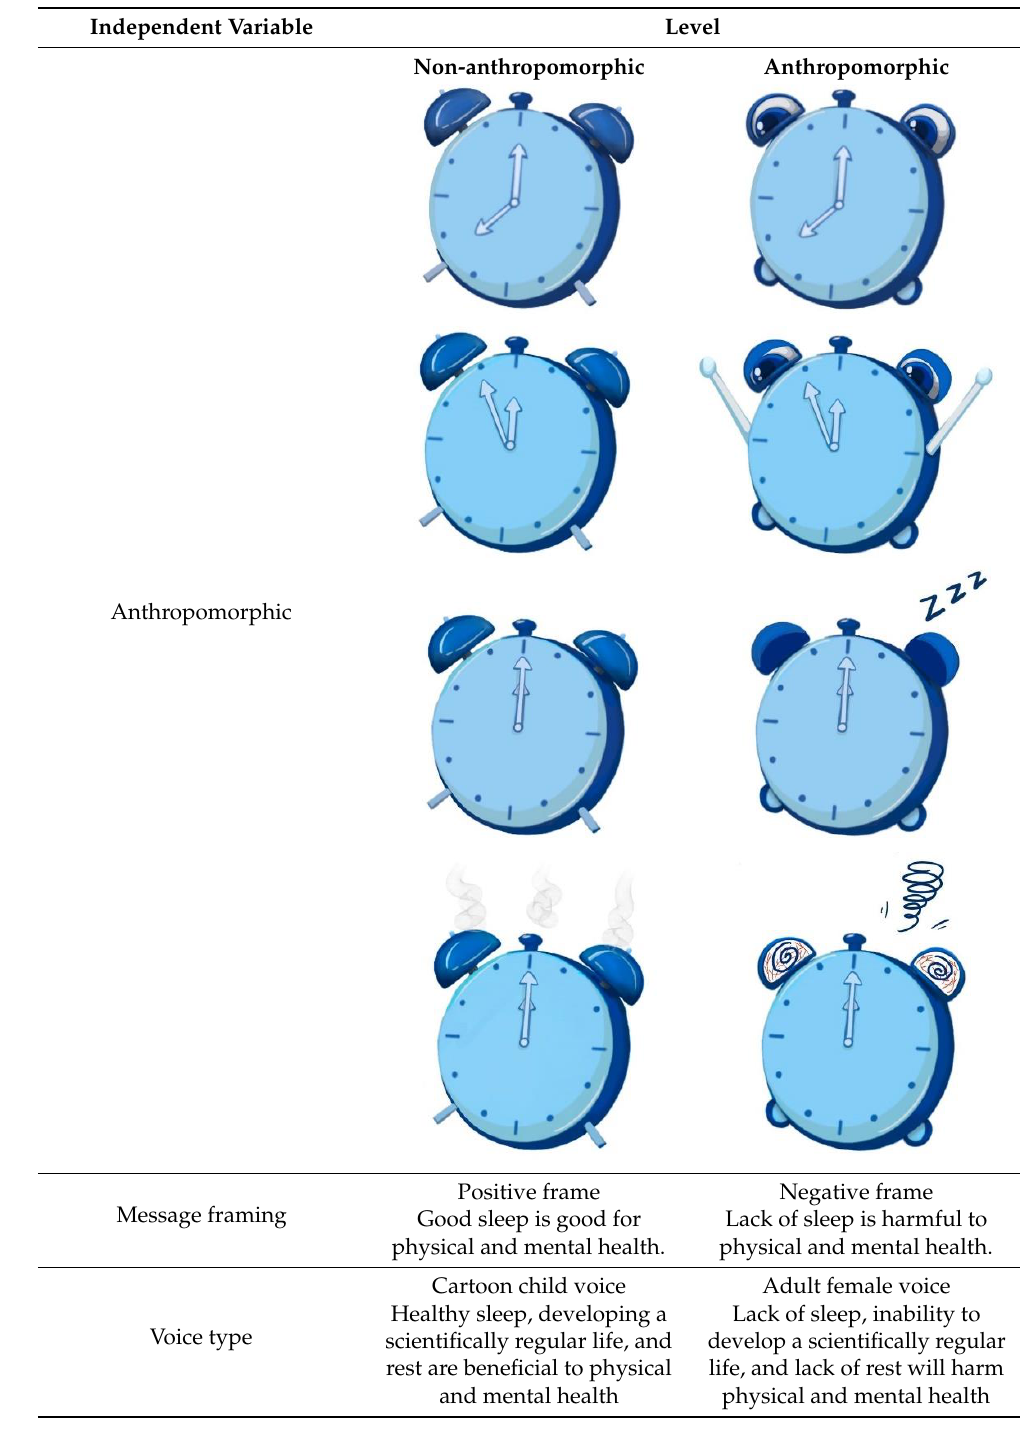
Table 1. The experimental stimulus designs.